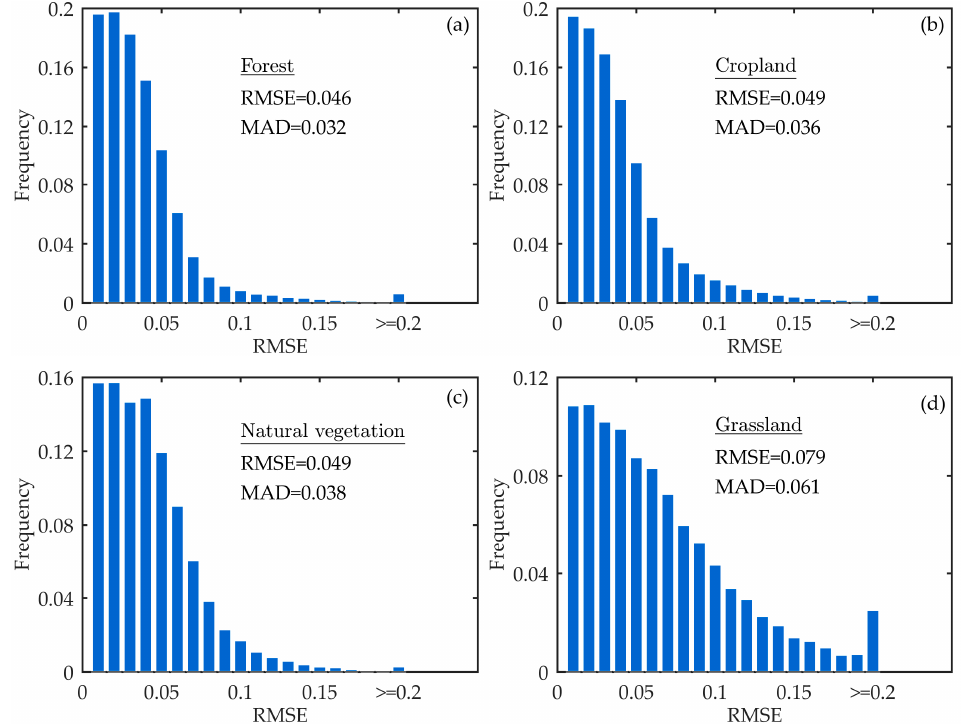
Figure A1. Frequencies of RMSE for different vegetation types. ( a ) Forest; ( b ) Cropland; ( c ) Natural vegetation; ( d ) Grassland.